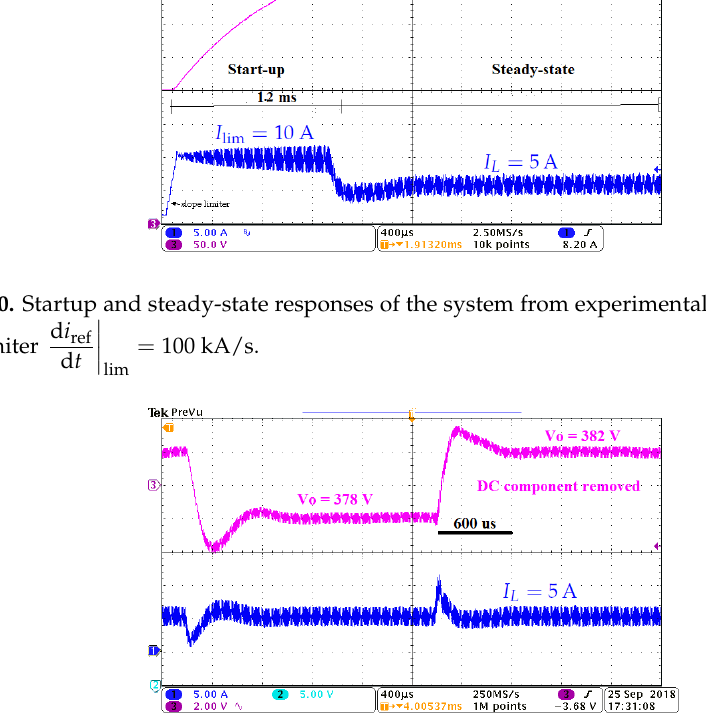
Figure 21. Response to a 4 V step change in the voltage reference from experimental measurements. ± DC component has been removed from the output voltage.